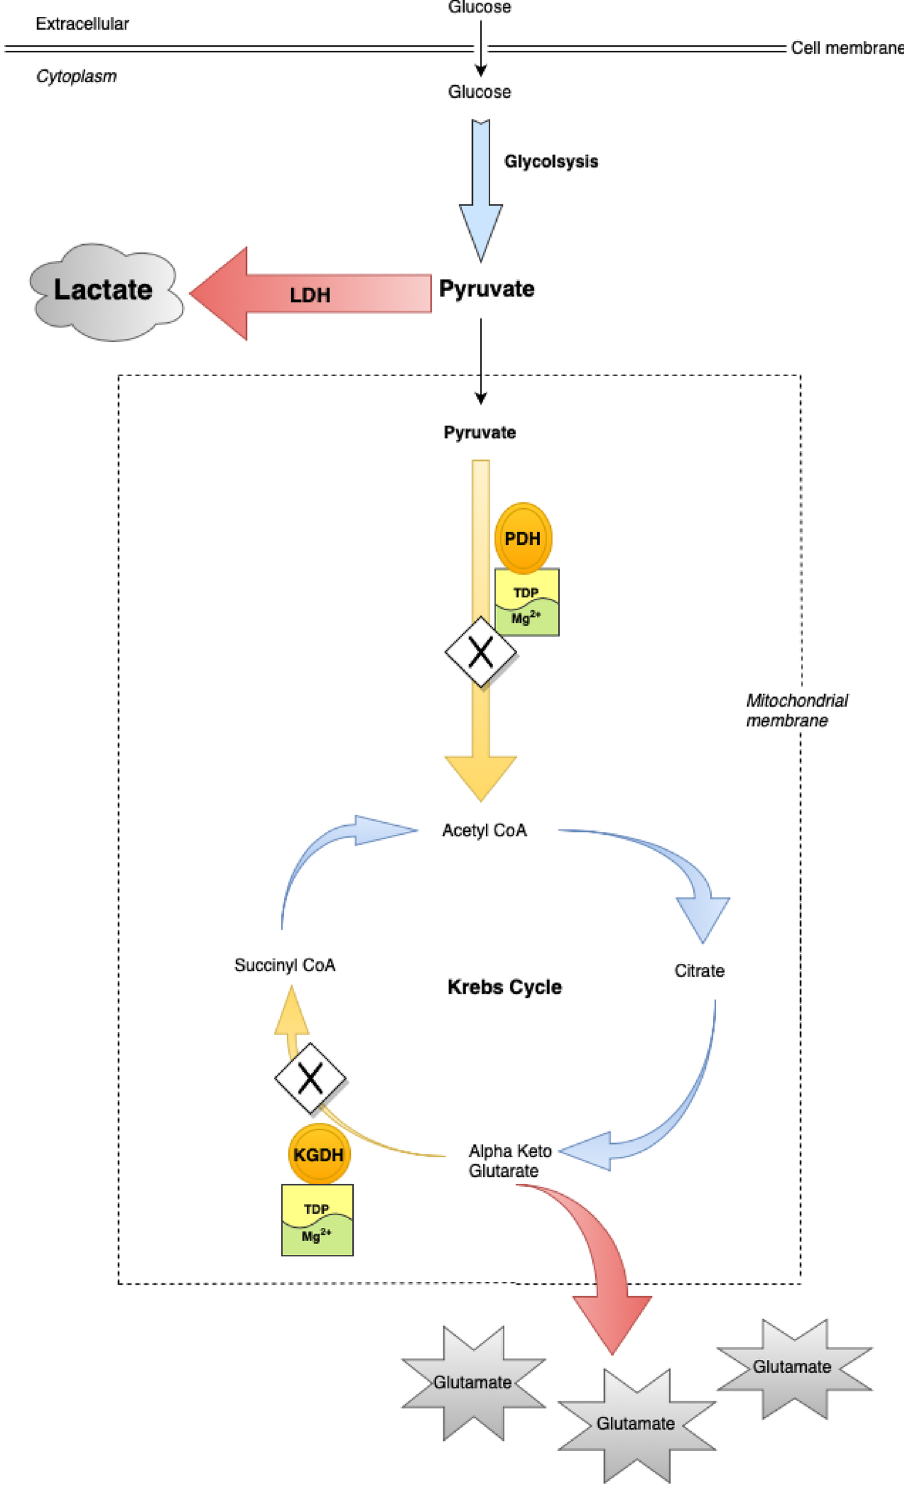
Figure 1. Pseudo-hypoxic ‘Dirty burn’ metabolism resulting in increased lactate production during